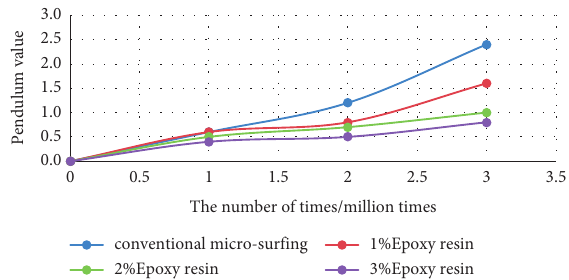
Figure 6: Curve of mass loss of epoxy high-performance microsurfacing.